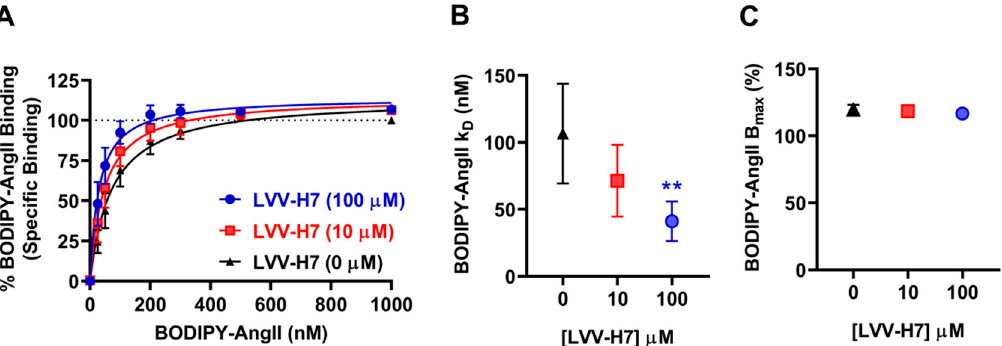
Figure 2. Specific binding of BODIPY-AngII to AT1R in the presence of LVV-H7 using NanoBRET assay in live HEK293FT cells. ( A ) HEK293FT cells transiently expressing Nluc-AT1R (NanoBRET donor) were first treated with 1 µ M olmesartan medoxomil or vehicle and then immediately treated with 0, 10, or 100 µ M LVV-H7. Following a 20-min incubation at 37 ◦ C, cells were then treated with increasing doses of BODIPY-AngII (NanoBRET acceptor) for 40 min at 37 ◦ C before BRET signals were measured. Specific binding curves were generated by subtracting olmesartan medoxomil-treated wells from vehicle-treated wells for each concentration of LVV-H7. Data are presented as % BODIPY-AngII binding by setting 100% as the maximal NanoBRET signals obtained with BODIPY-AngII in the absence of LVV-H7. ( B ) k D and ( C ) B max data from panel ( A ). The vehicle B max value shown in panel ( C ) corresponds to the saturating value estimated by Prism analysis in panel ( A ) which is beyond the actual experimental B max value. Data are mean ± SEM of six independent experiments performed in duplicate. ** p -value < 0.01.